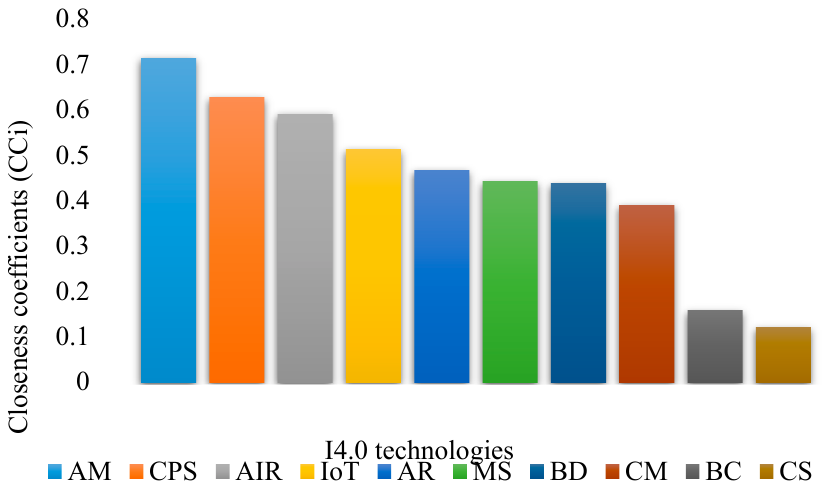
Figure 6. I4.0 technologies ranking.